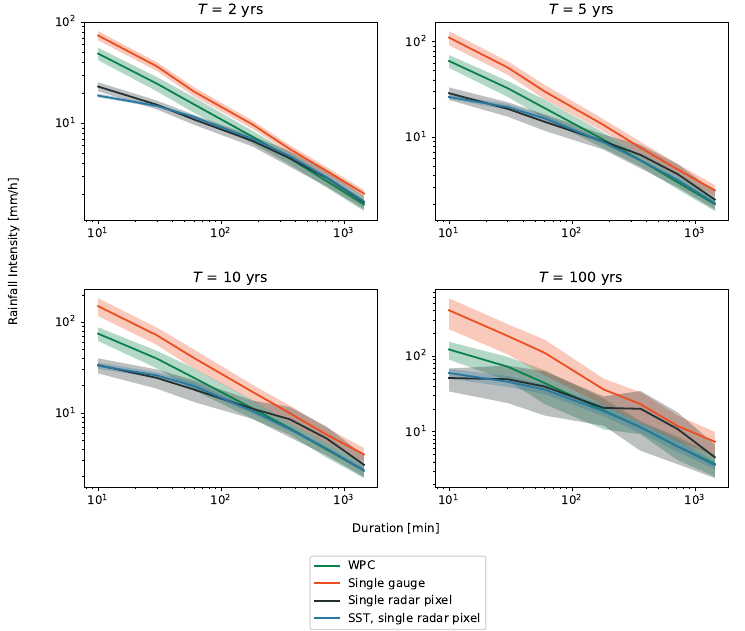
Figure 7. IDF-curves (10 min to 1440 min) for the regional model (green, WPC); long-term rain gauge, derived from GPD fit (orange); single radar pixel, derived from GPD fit (black, Radar), and the SST framework (blue, SST). The shaded area depicts 95% confidence interval, and total ensemble spread for SST values. Each curve represents a return level of: 2, 5, 10, and 100